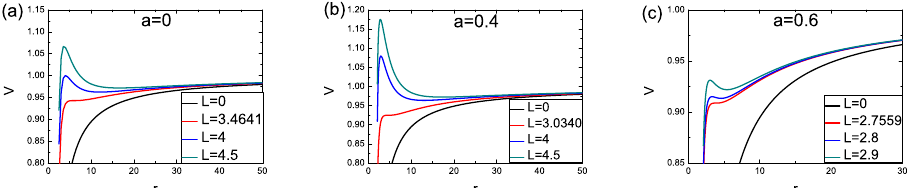
Figure 4. The black hole spins are ( a ) a = 0, ( b ) a = 0.4 and ( c ) a = 0.6. Effective potentials for different angular momenta L of test particles. The other parameters are Q ∗ = 0 and B ∗ = 0.